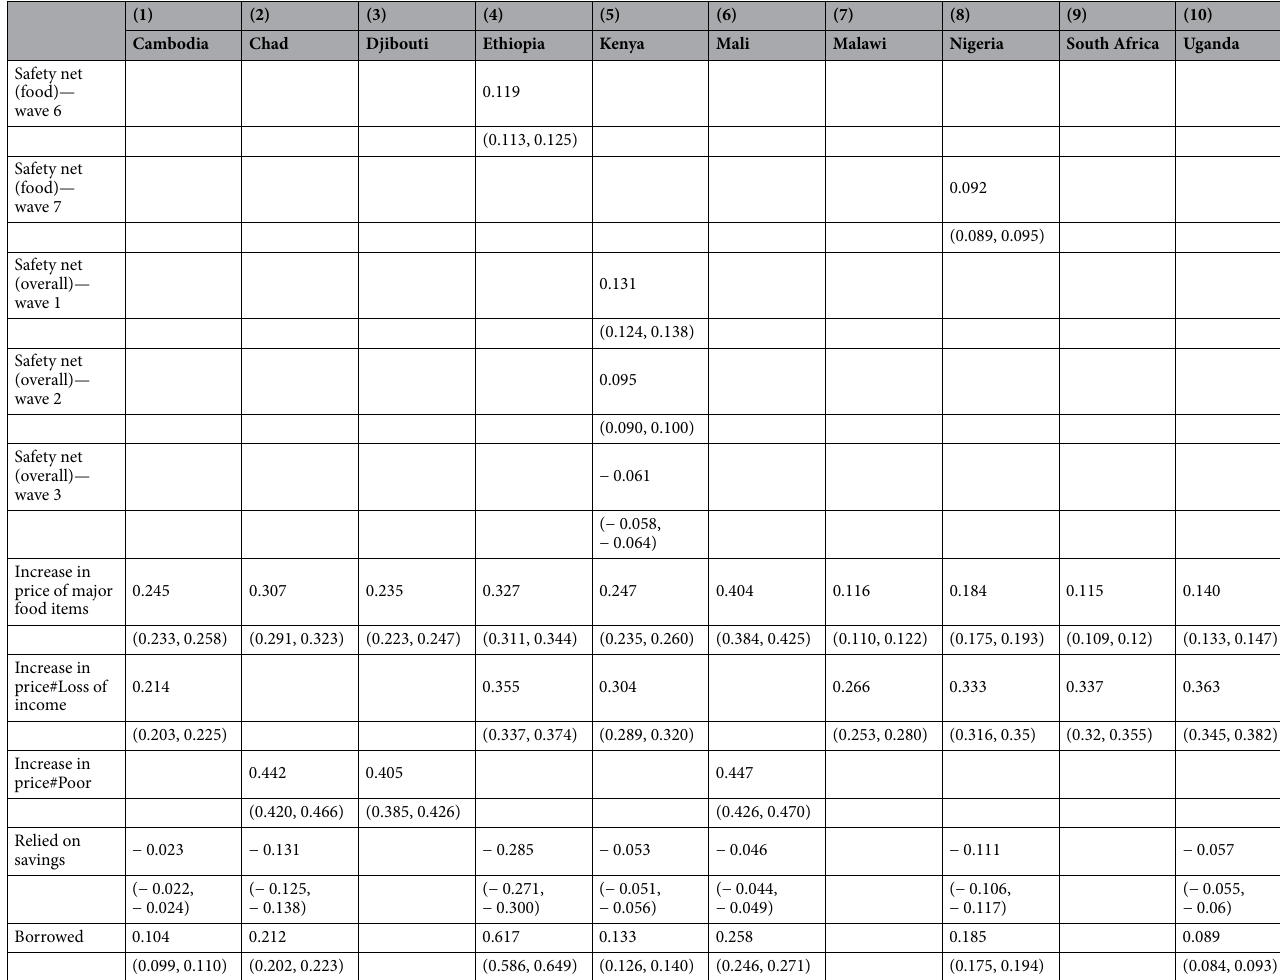
Table 5. Determinants of food insecurity—went hungry. 95% CI in parentheses.